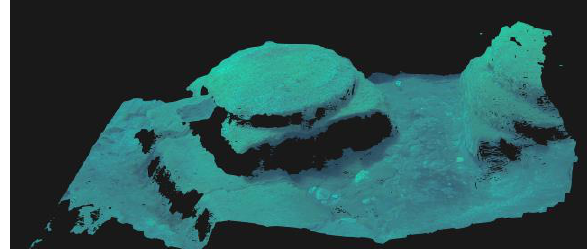
Figure 7. pose graph without additional edge (1), pose graph with additional edges (2) Figure 9. Lipari particular RGB-D (1)